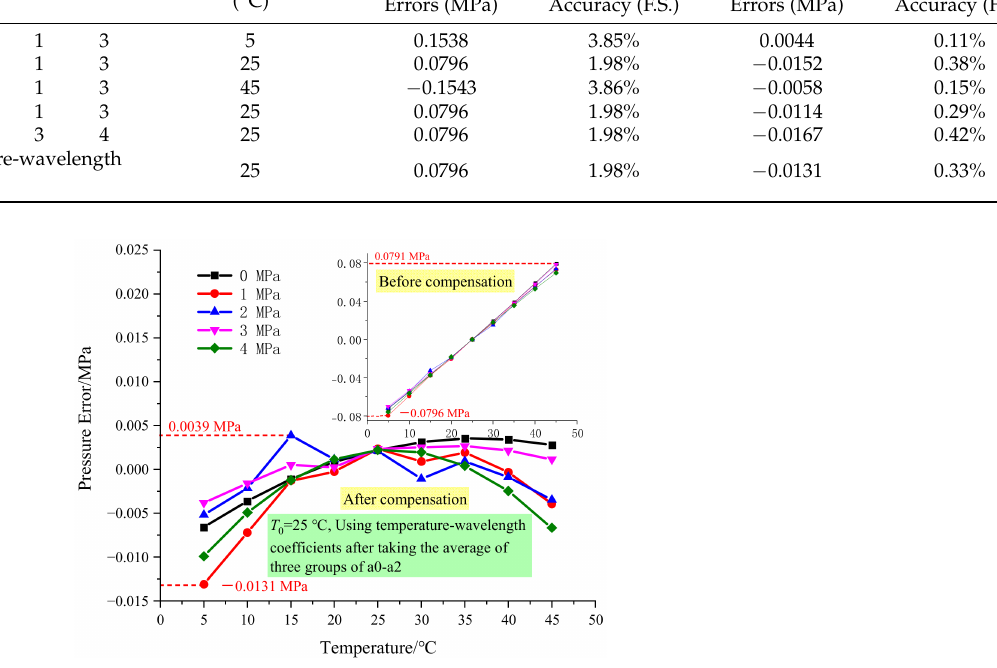
Figure 10. Errors with temperature compensation using averaged temperature-wavelength coeffi-